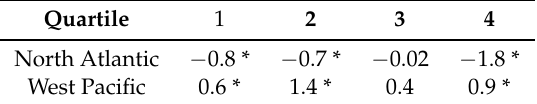
Figure 5. Moving decadal means of the LMI latitude of the strongest quartile of TCs in the ( a ) North Atlantic and ( b ) West Pacific basins. The strongest storms are in the fourth quartile. The significant linear trends ( p < 0.05) in LMI latitude are shown with a solid line. Dashed lines are shown for the other quantiles. Table 2. Decadal rate of LMI migration in each basin ( ◦ latitude), separated by quartiles of wind speed. The strongest storms are in the fourth quartile. Asterisks (*) indicate a significant trend ( p < 0.05).